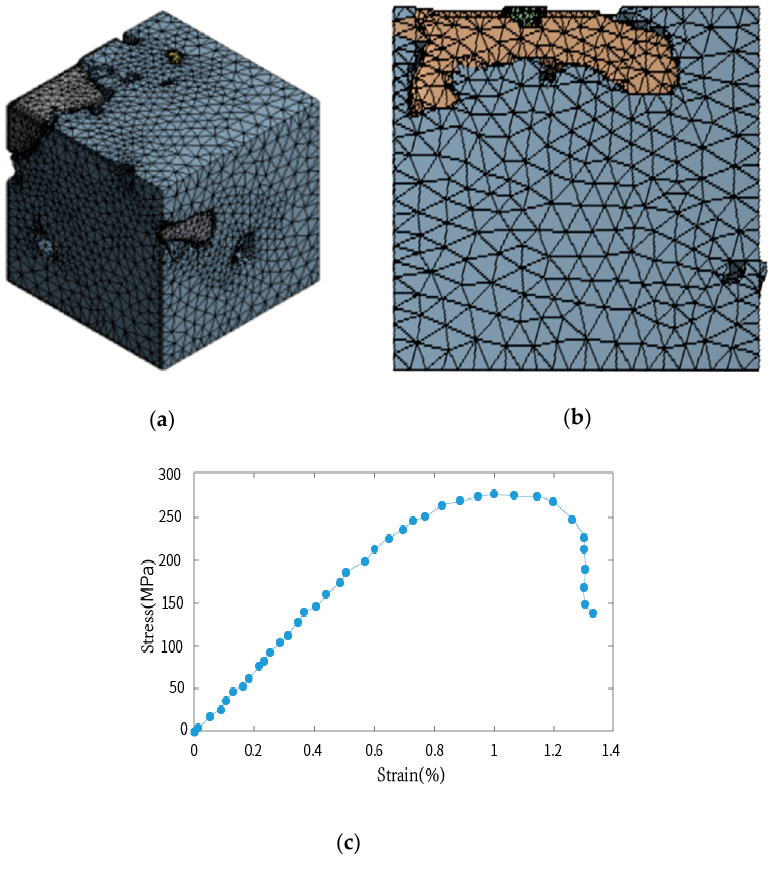
Figure 4. The mesh division and stress–strain curve of the simulation of tested cores: ( a ) mesh division of the core without fractures, ( b ) mesh division for the core with fractures, and ( c ) stress–strain curve.